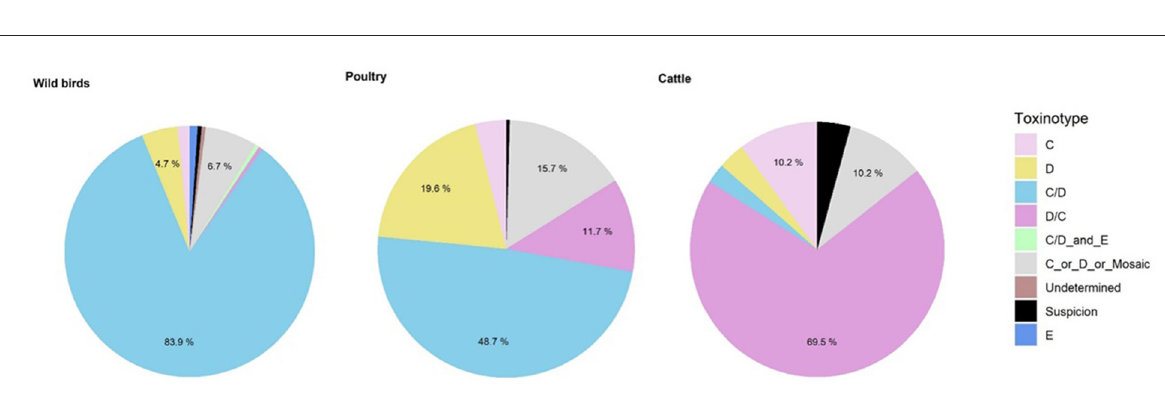
FIGURE6 Distribution of botulism toxins from 2010 to 2019 for wild birds ( n = 193), poultry ( n = 231) and cattle ( n =